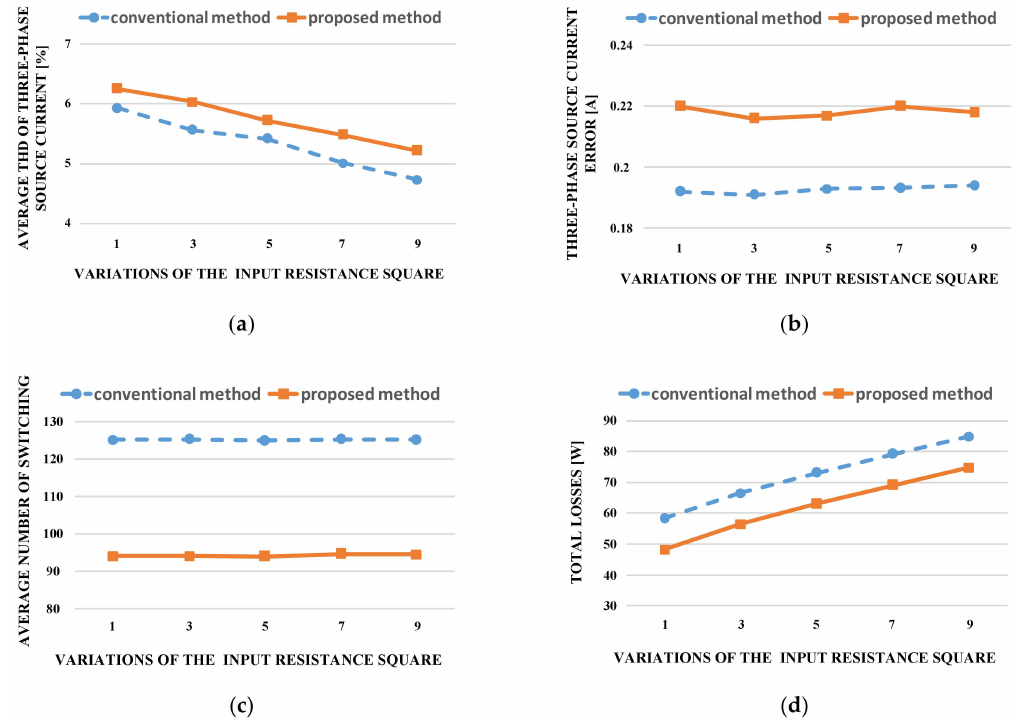
Figure 15. Performance comparison obtained from the conventional method and the proposed method vs. the input resistance square: ( a ) Average THD of three-phase source current; ( b ) three-phase source current error; ( c ) average number of switching; and ( d ) total losses ( | v s | = 100 V, V ∗ L s = 10 mH, and f s = 20 kHz).